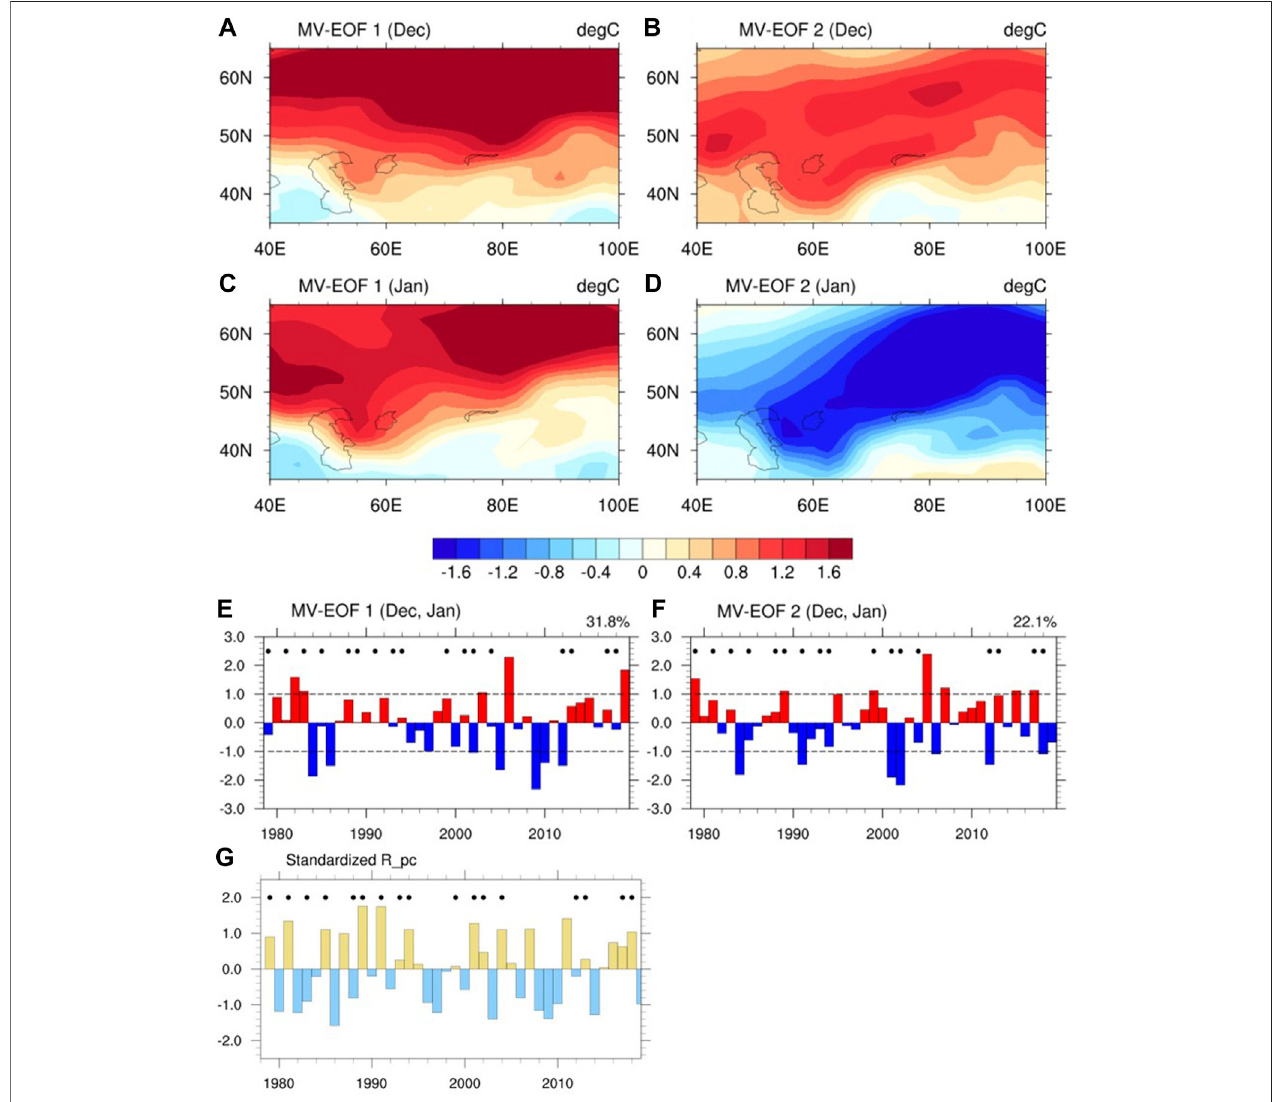
FIGURE 2 | Spatial distributions of the fi rst MV-EOF mode of (A) December and (C) January SATAs during 1979 – 2017 (E) Normalized time series of the standardized fi rst principal component (PC1), with the proportion of the explained covariance of the fi rst mode given in the top-right corner (B,D,F) As in (A,C,E) but for the second MV-EOF mode and PC2 (G) Time series of the standardized R pc 2 during 1979 – 2017. The black dots represent the year in which the December and following-January SATA are of opposite sign.